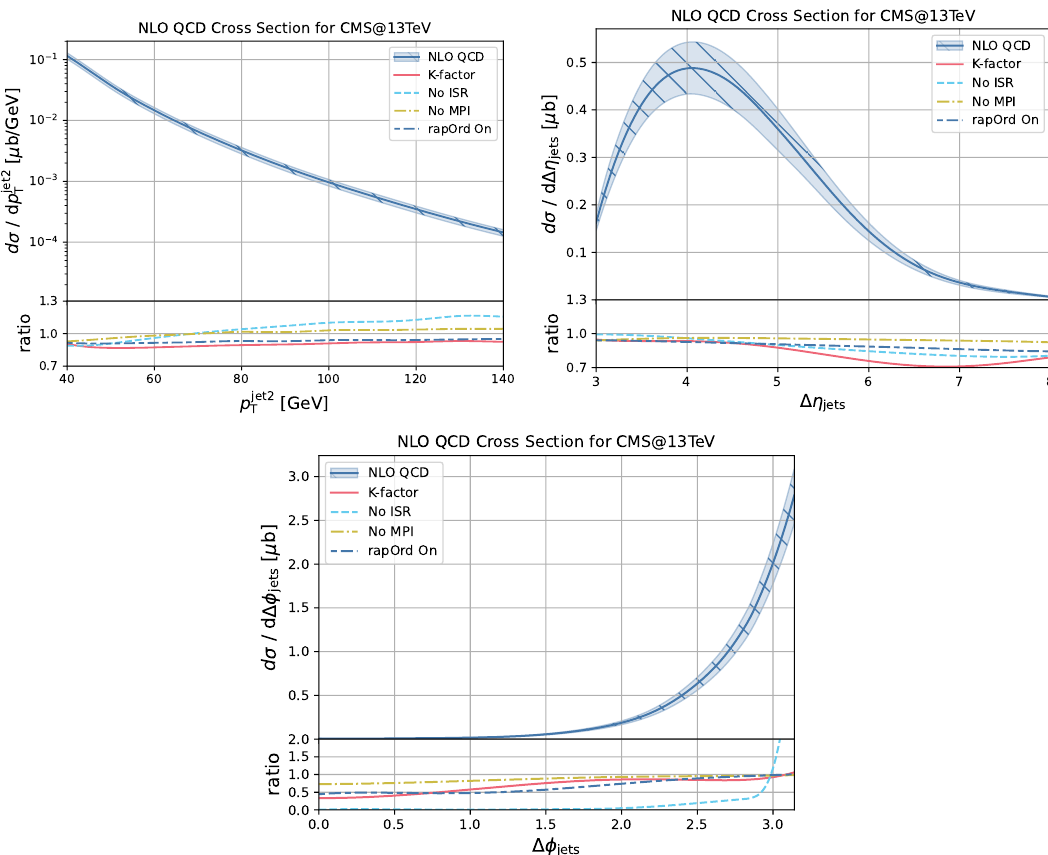
Figure 16 . Inclusive dijet cross sections for CMS conditions at a center-of-mass energy of 13 TeV as a function of p jet2 , ∆ η , and ∆ φ . The upper panels show the absolute cross section at jets jets T NLO+PS and their scale uncertainty based on the seven-point method. The lower panels show the NLO/LO K -factor (red) as well as the impact of initial-state radiation (ISR, light blue), multi- parton interactions (MPI, yellow) and rapidity ordering in the parton shower (rapOrd On, dark blue) in LO PYTHIA8 simulations as a ratio with respect to using the CP1